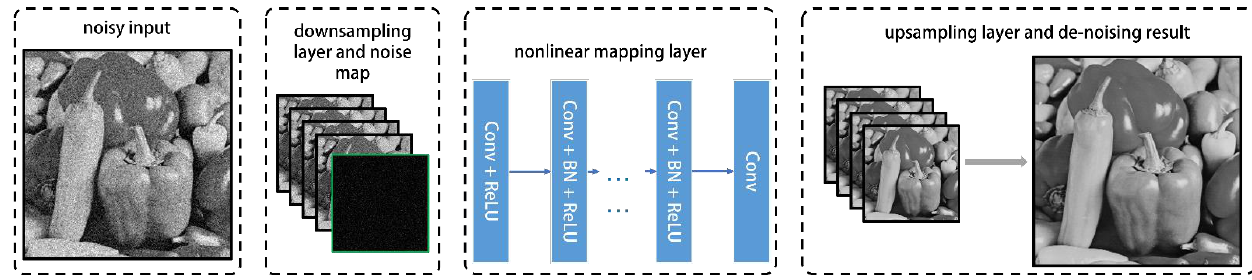
Figure 7. Architecture of FFDNet [22].